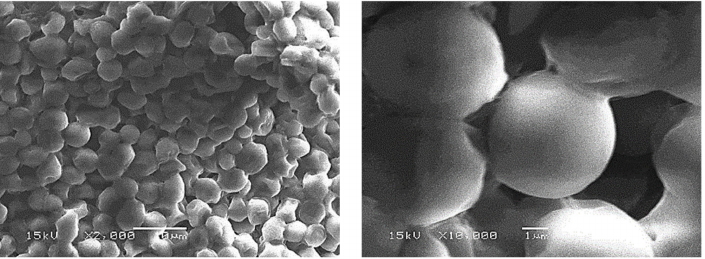
Figure 2. MicrographstakenthroughScanningElectronMicroscopy(SEM)showingthenearlymonodisperse size distribution of light lees (magnification × 2000 left– × 10,000